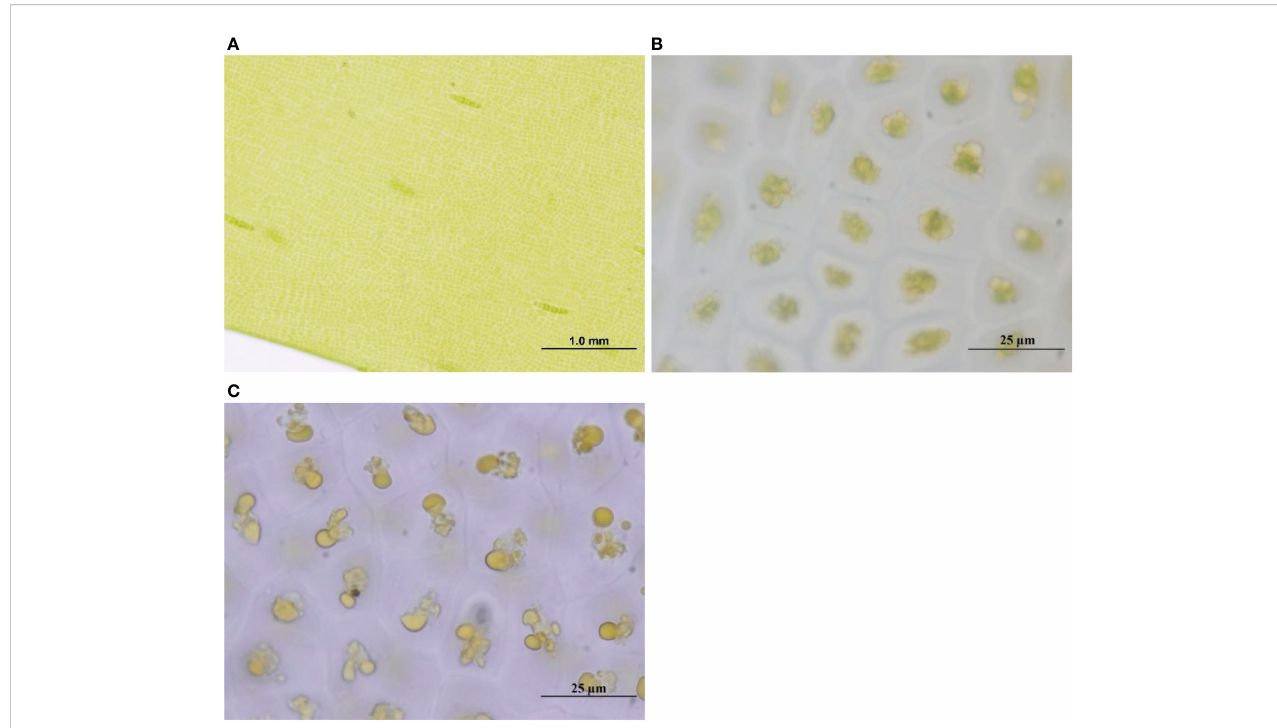
FIGURE 1 The cell structure of fresh U. prolifera at the initial stage of degradation (A) and 35 days (B) under the microscope, and that of pre-decomposed U. prolifera at the initial stage (C)